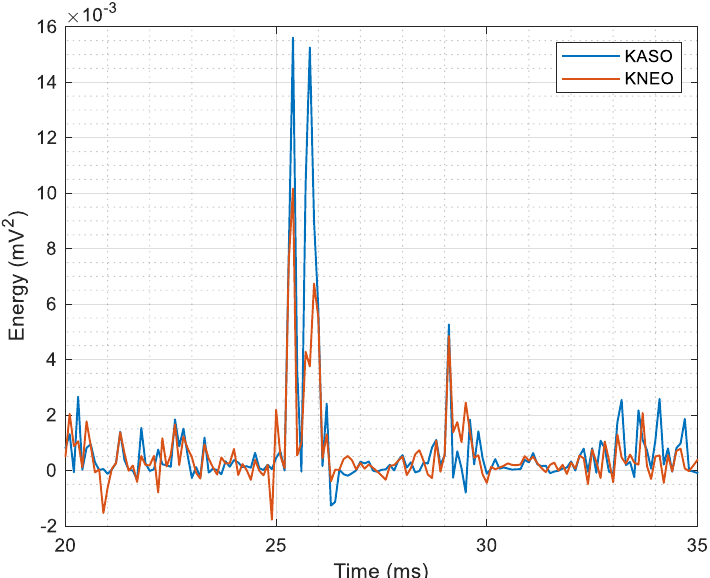
Figure 4. A 15 ms frame of synthetic extracellular signal after applying the energy operators: k ASO (blue) and k NEO (red). The tuning parameter is 4. It can be seen that the spike at 25.5 ms is more enhanced by the ASO operator. However, with both operators the energy signal provides for the same spike two peaks that might cause a double detection. This is another reason to use a smoothing window, not only to smooth the spurious noise but also to reduce the multiple detection of the same spike.